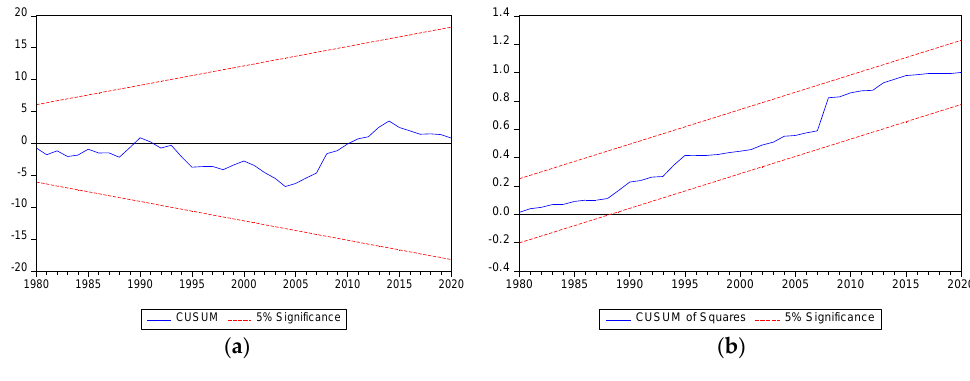
Figure 8. ( a ) CUSUM Test for Model 2. ( b ) CUSUMQ Test for Model 2.